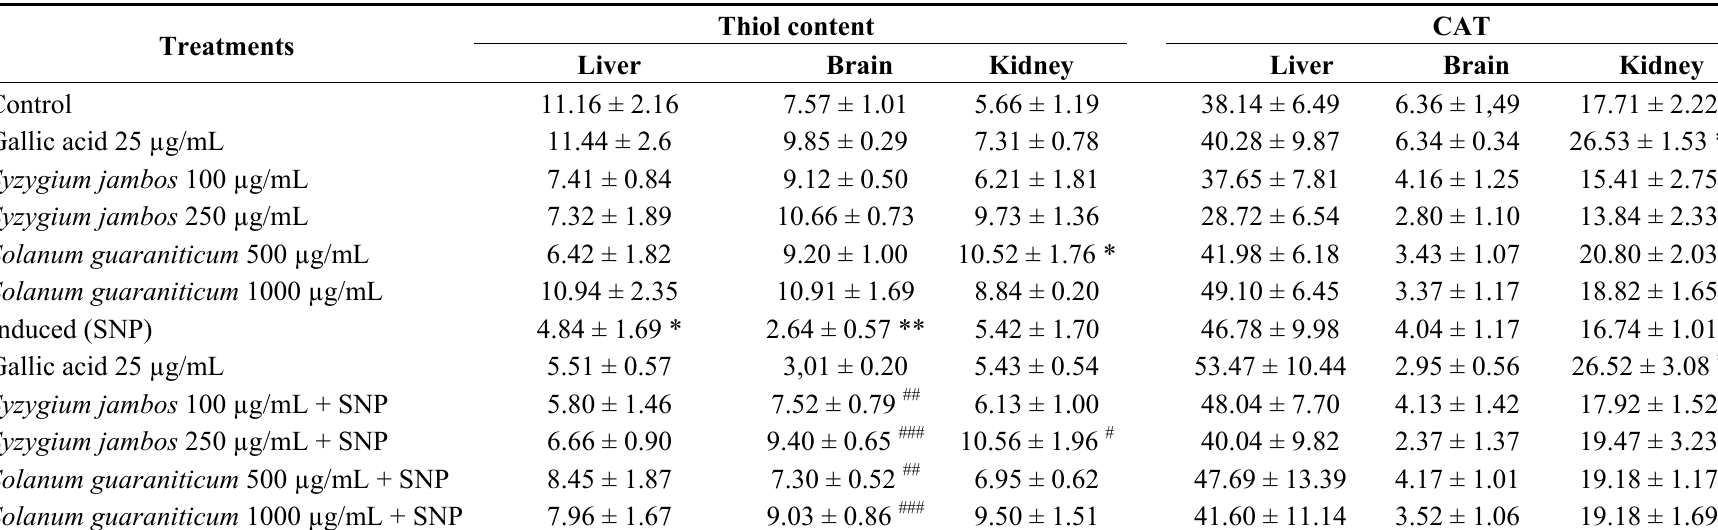
Table 4. Effect of aqueous extracts of Syzygium jambos and Solanum guaraniticum on non-protein thiol (NPSH) content and catalase activity in the liver, brain and kidney of